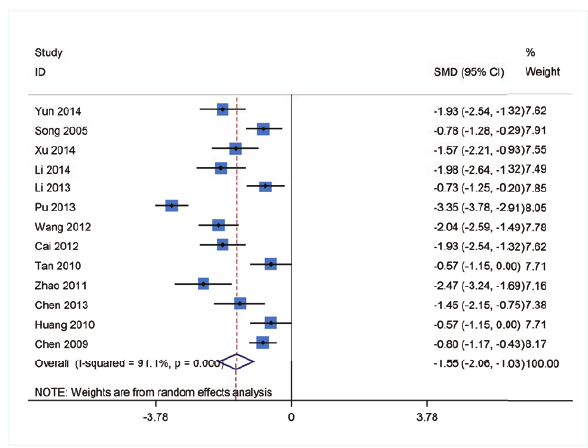
Figure 4: Forest plot of 24h urinary protein for tripterygium glycosi- des in treatment of stage IV diabetic nephropathy. (The squares and horizontal lines demonstrate the study-specific OR and 95% CI. The area of the squares reflects the study specific weight (inverse of the variance). The diamond represents the pooled OR and 95%